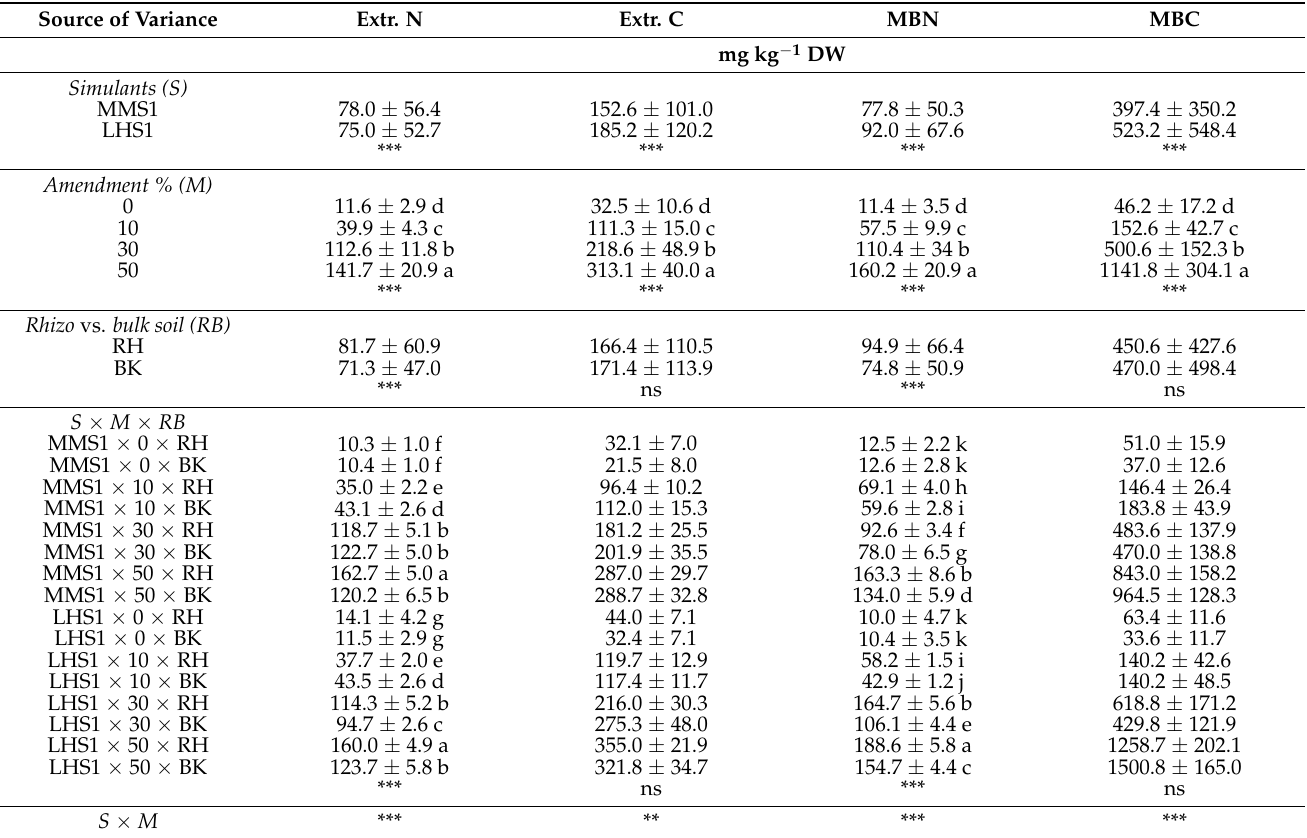
Table 4. Extractable nitrogen (Extr. N) and carbon (Extr. C), microbial biomass nitrogen (MBN), and carbon (MBC) in different mixtures of MMS-1 or LHS-1 simulants and manure (simulant/manure rates: 100:0, 90:10, 70:30, 50:50; w / w %), separated in rhizo and bulk soil after lettuce